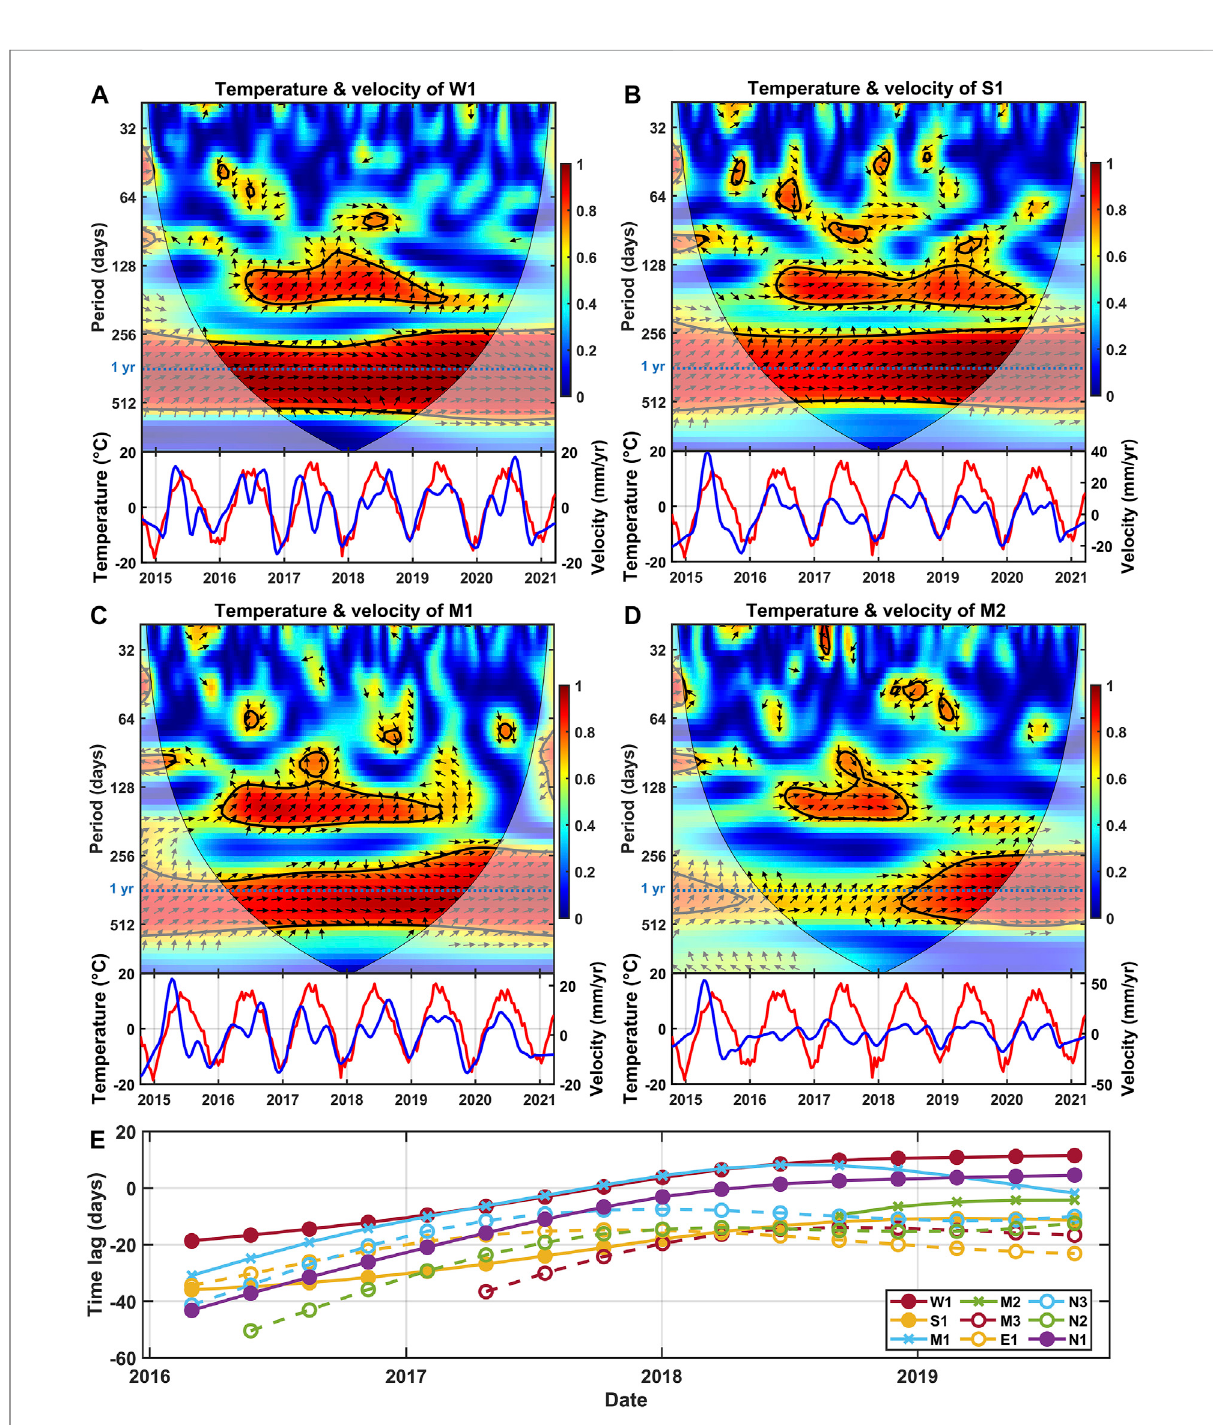
Wavelet coherence on different pairs of time series: (A) temperature and the velocity of W1, (B) temperature and the velocity of S1, (C) temperature and the velocity of M1, (D) temperature and the velocity of M2, and (E) variations of time lag: that at the period of 1 year